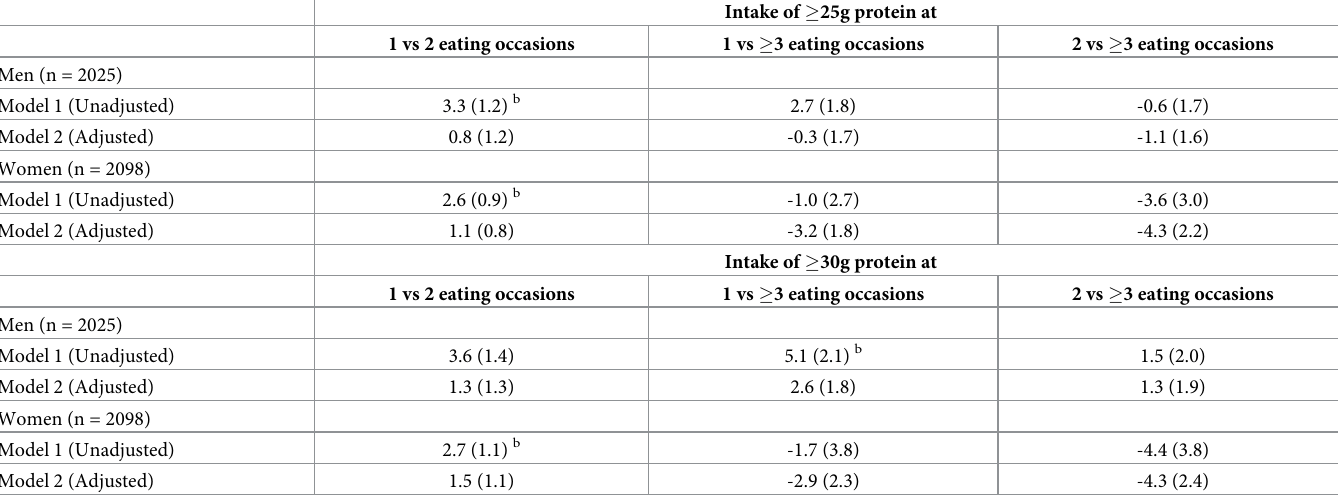
Table 4. Association between grip strength and intake of (cid:21) 25g and (cid:21) 30g protein at 1 vs. 2, and 3 or more eating occasions before and after adjusting for potential confounders a .